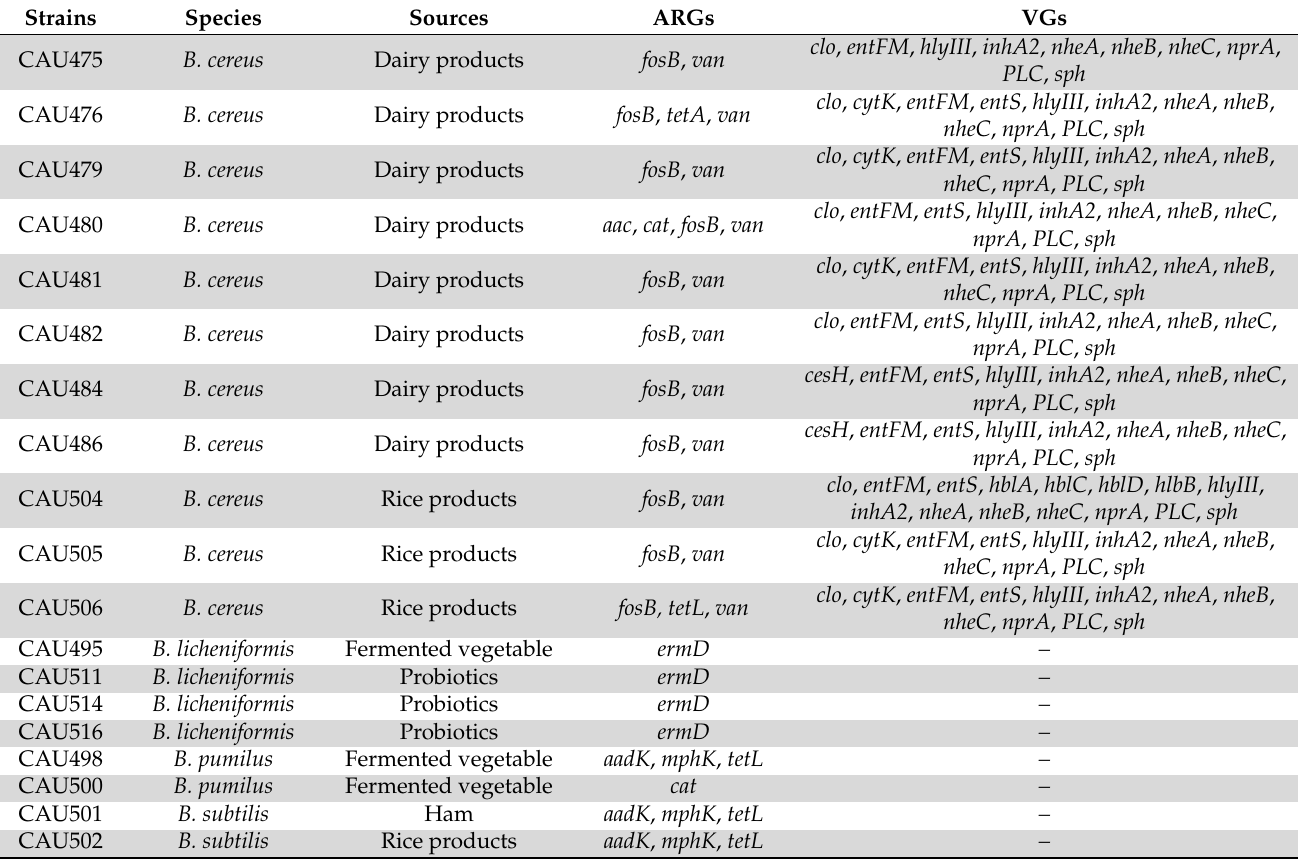
Table 3. The antibiotic resistance genes and virulence genes of Bacillus